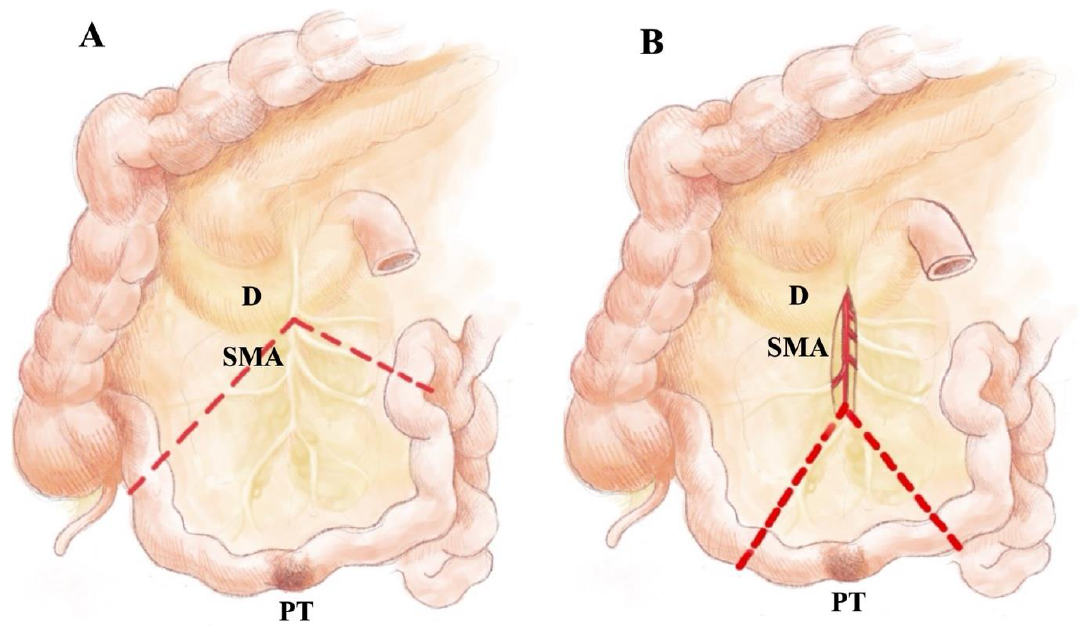
Figure 2. Schematic graph of conventional ( A ) and vessel-sparing lymphadenectomy ( B ) in SI- NENs. Red dashed line — dissection line; encircled area in B — superior mesenteric artery as well as right colic artery and vein were dissected free from soft tissue but not transected. D — duodenum; SMA — superior mesenteric artery; PT — primary tumor.